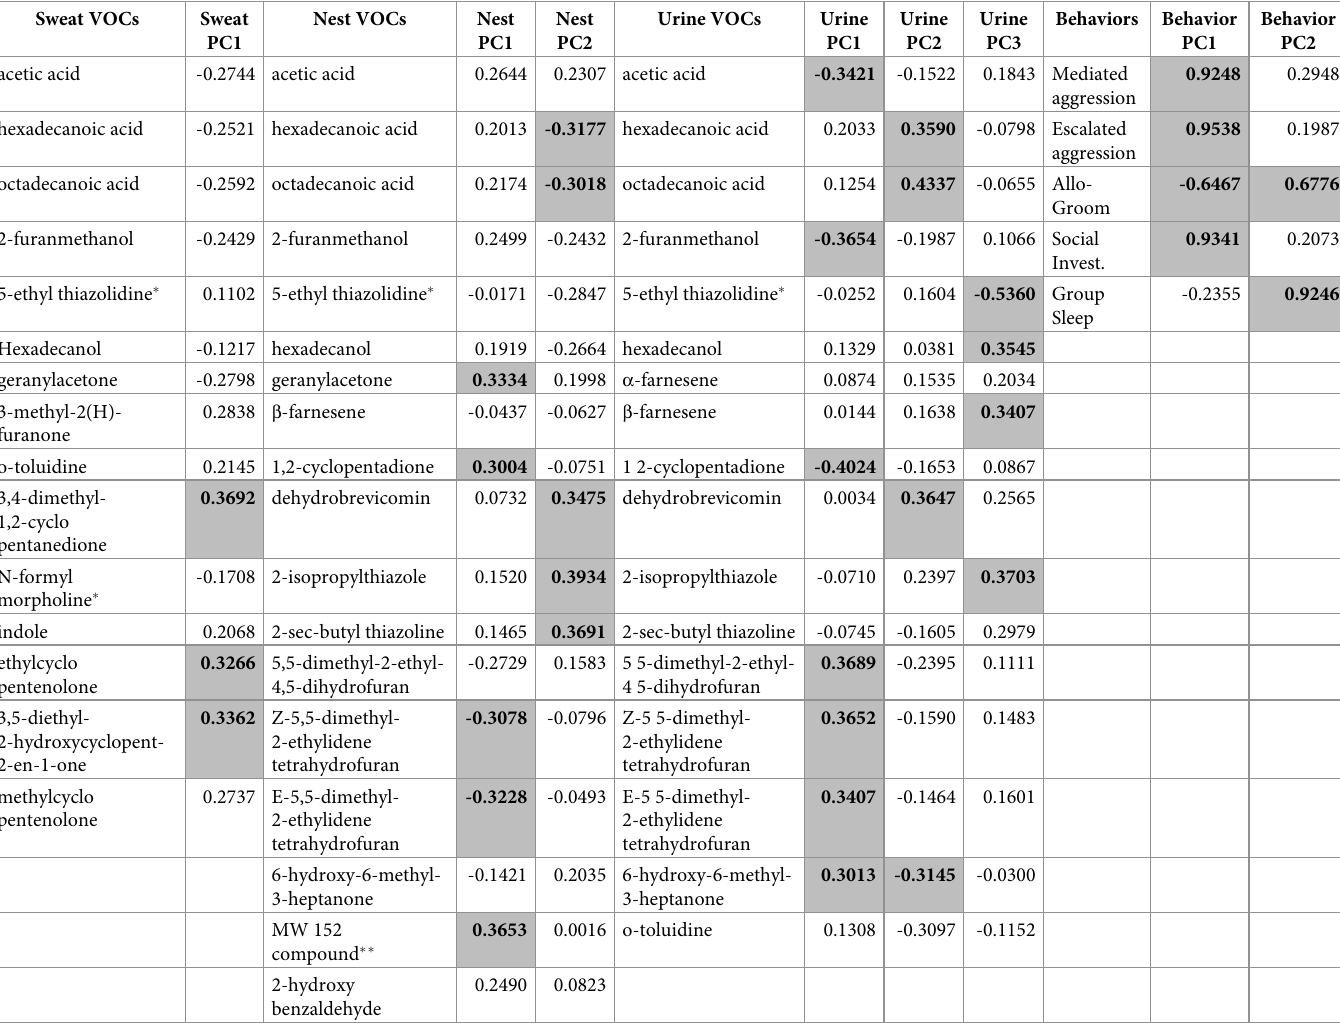
Table 2. Loading values for all Principal Components (PCs) retained for mixed